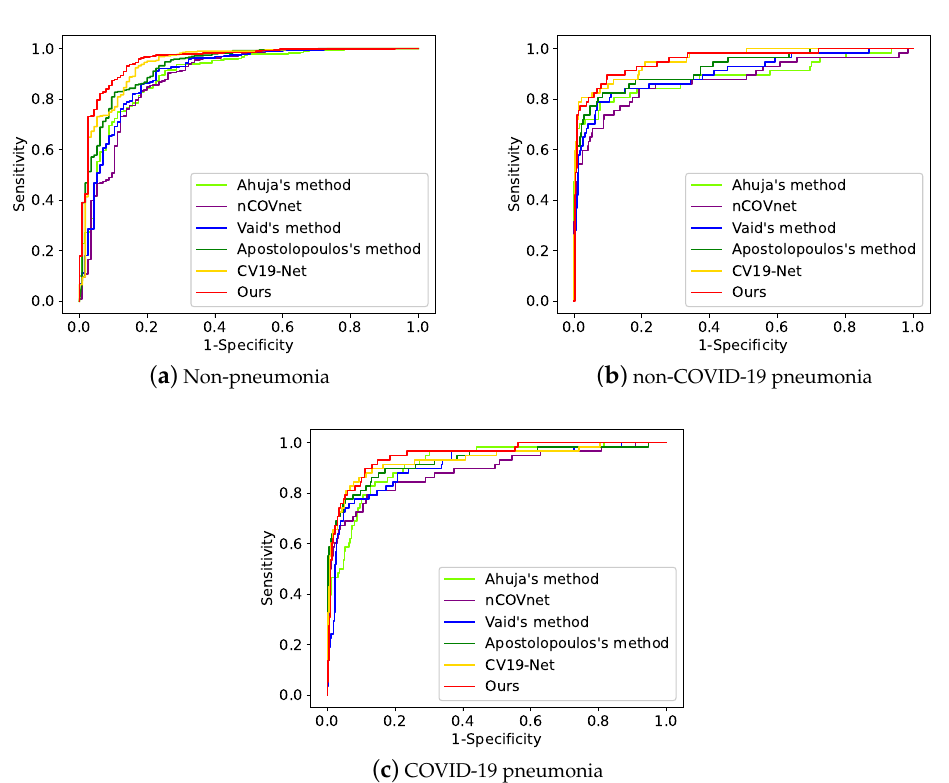
Figure 3. The ROC curve of the peer methods (i.e., Ahuja’s method [30], nCOVnet [31], Apostolopou- los’s method [33], and CV19-Net [6]) and ours on the three classes.